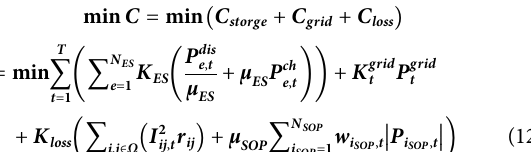
FIGURE 2 Model solving